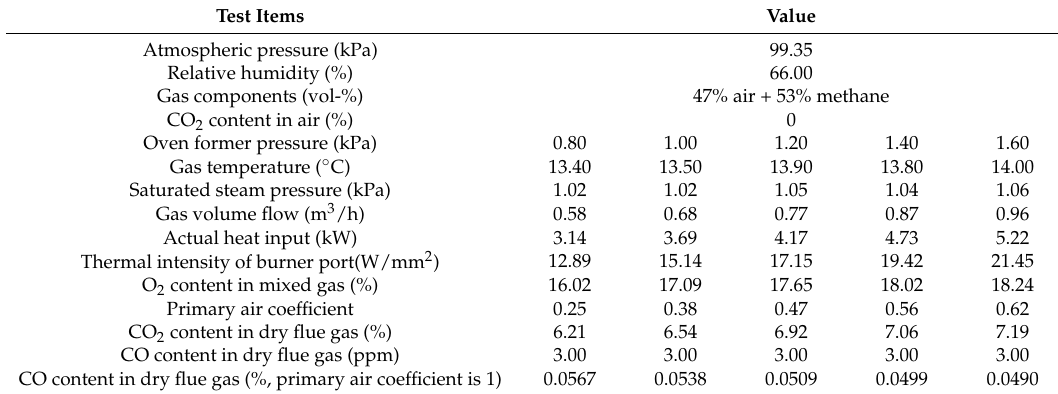
Table 6. Testing data of CO content in the fume gas of the substitute gas.